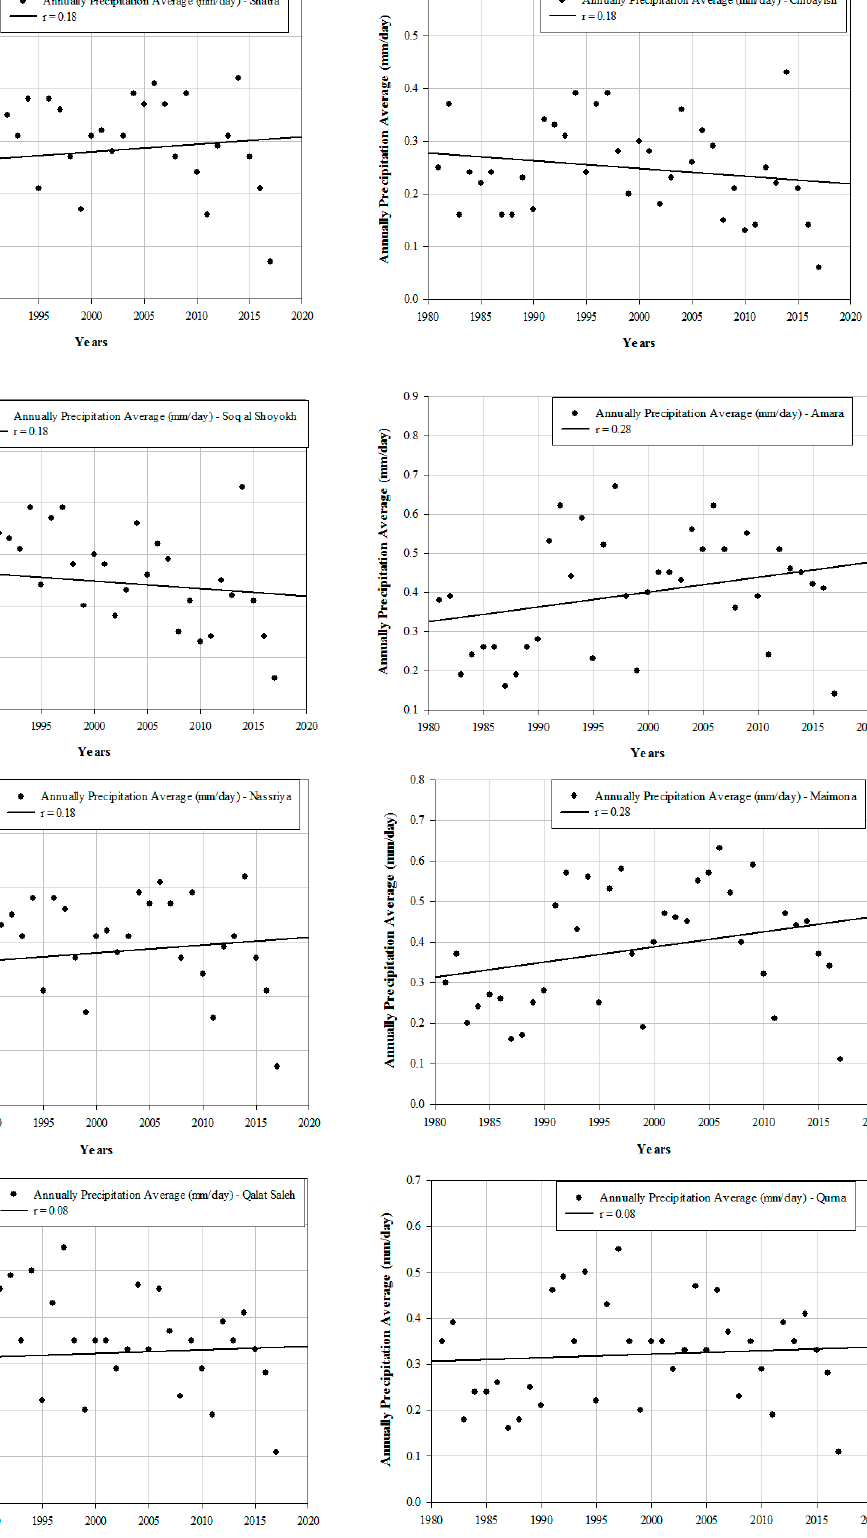
Figure 8. Changes of the Annual precipitation average in period of 1981–2016.